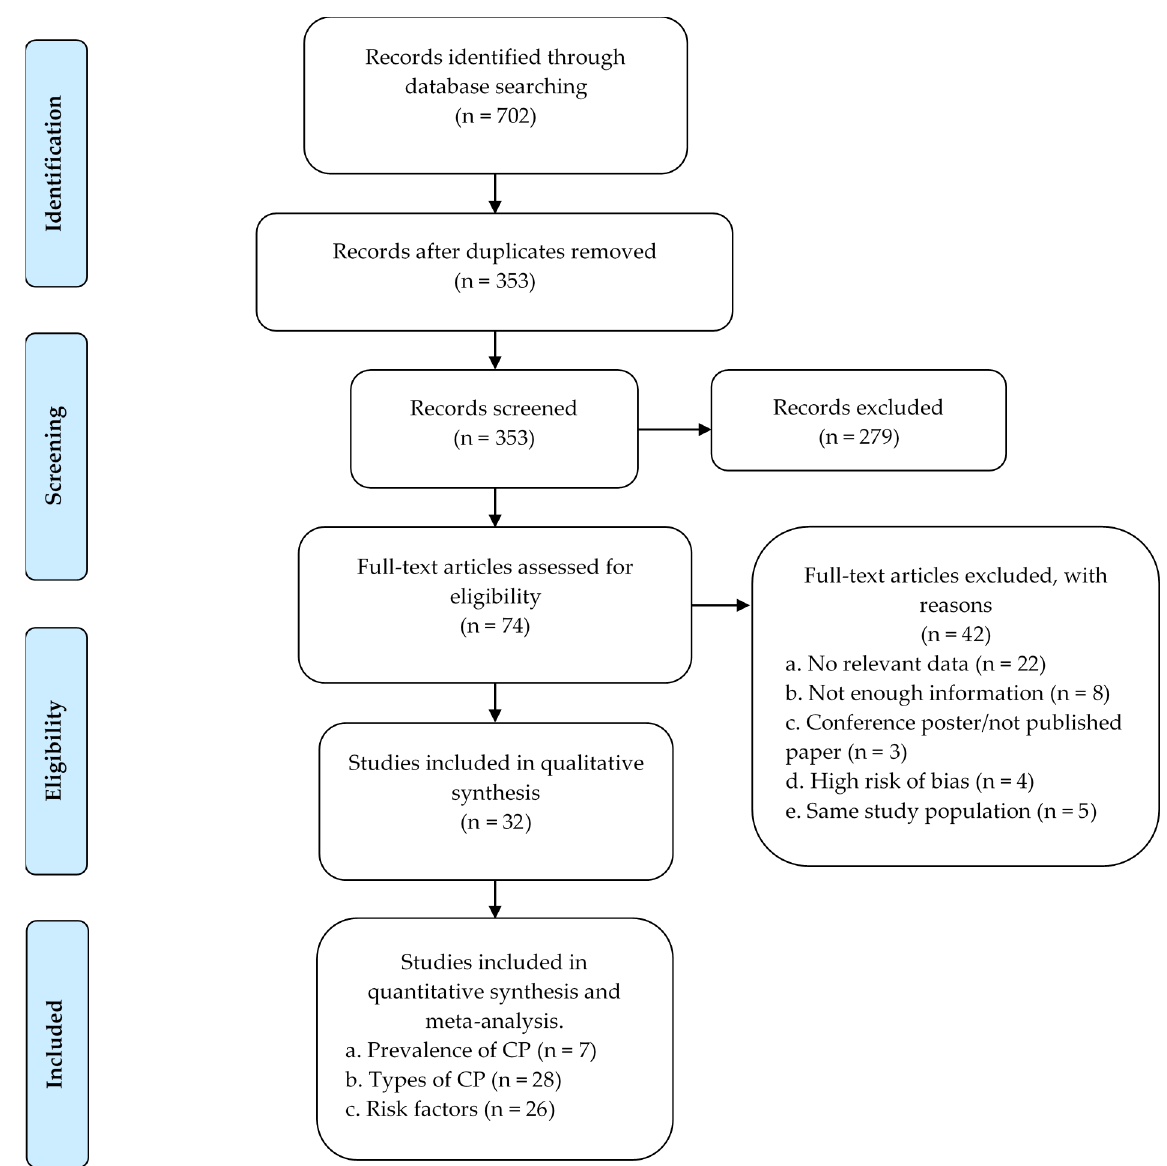
Figure 1. PRISMA flow diagram for a systematic literature review and study selection; CP among children and adolescents in ASCs.